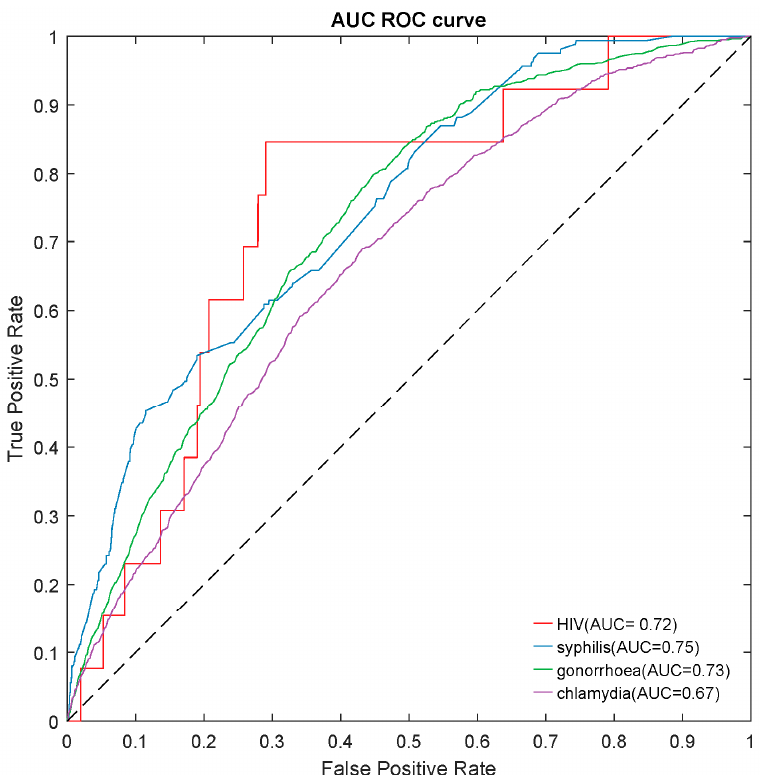
Figure 2. The area under the ROC curve (AUROC) of a risk-prediction tool for predicting HIV/STIs over the next 12 months on testing datasets. STI: syphilis, gonorrhoea, and chlamydia.